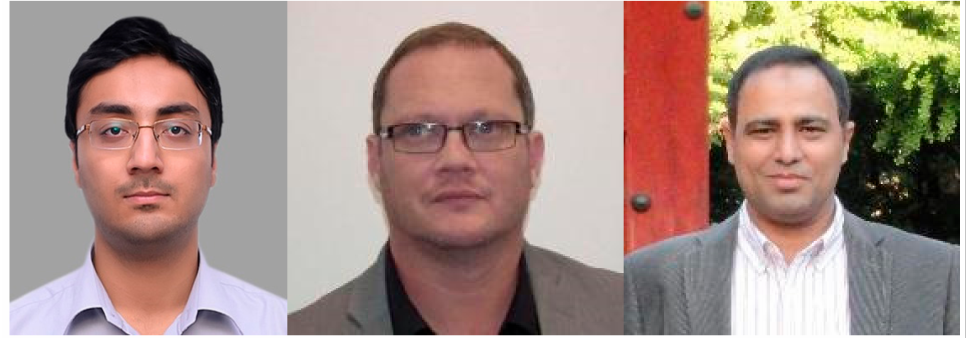
Figure 1. Muhammad Hammad Saleem, Johan Potgieter and Khalid Mahmood Arif (from left to